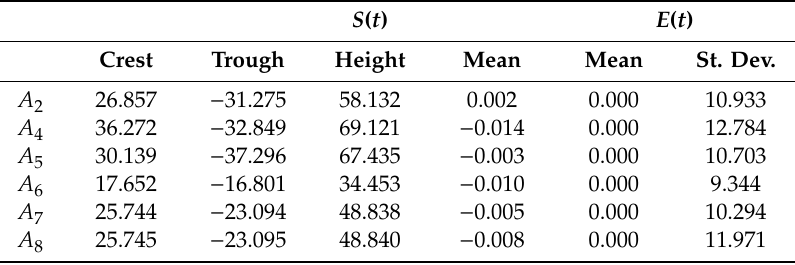
Table 3. Descriptive summary of the seasonal and error components of A 2 , A 4 , A 5 , A 6 , A 7 , and A 8 . The unit is ppb. S ( t ): seasonal component and E ( t ): trend component.